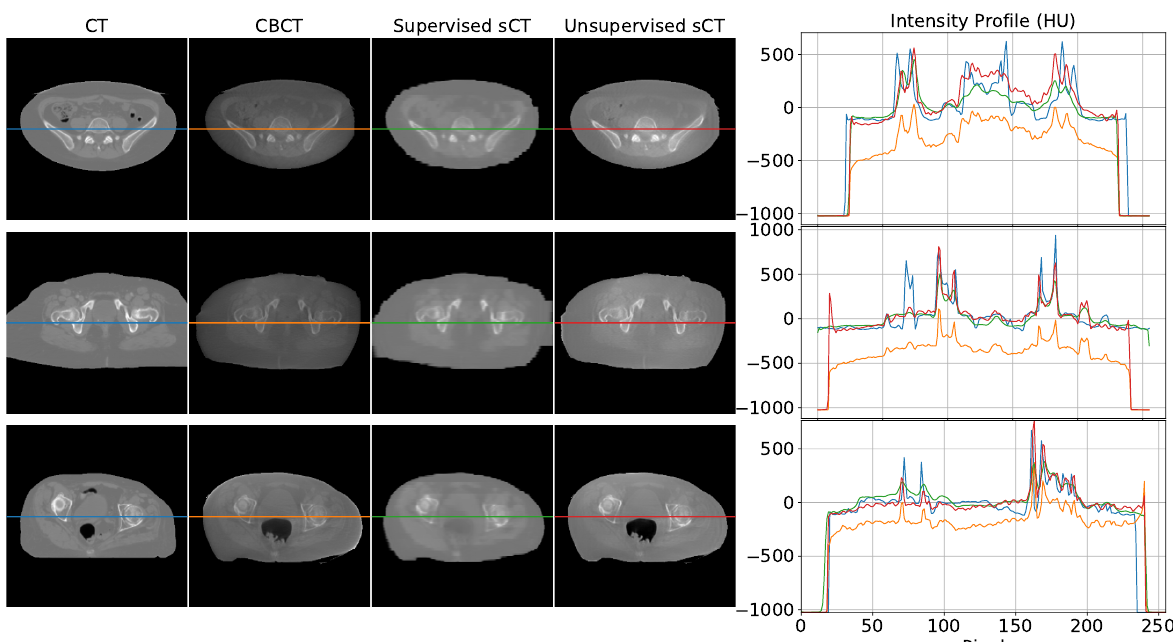
Figure 6. Visual comparison between some axial slices depicted in every modality: CT, CBCT, sCT supervised, and sCT unsupervised. Every row corresponds to a different example taken from a different subject. The rightmost part of the figure compares the intensity profiles of the central line of the images, highlighted by the central line in the four representations. Images are displayed with Window = 2000, Level = 0.